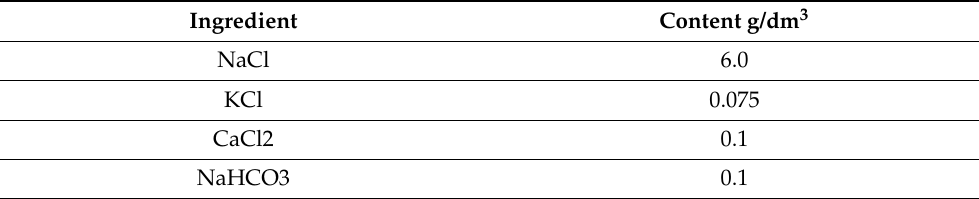
Table 3. Ringer’s solution was used for corrosion tests